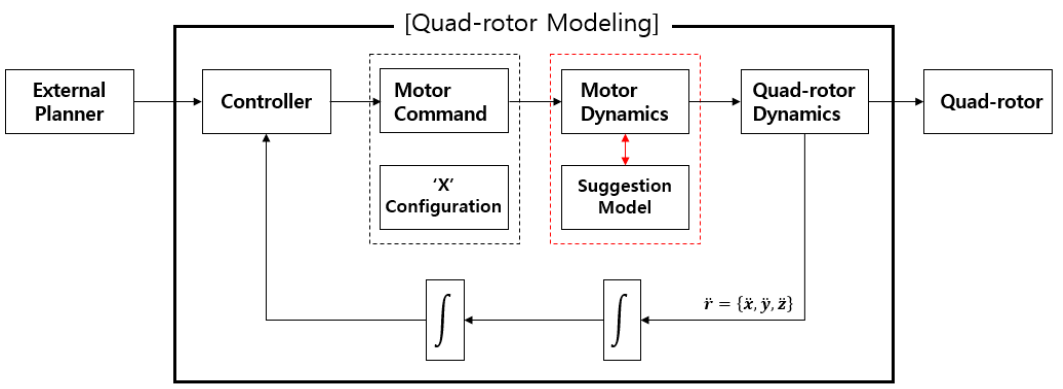
Figure 19. The block diagram of quad-rotor modeling.